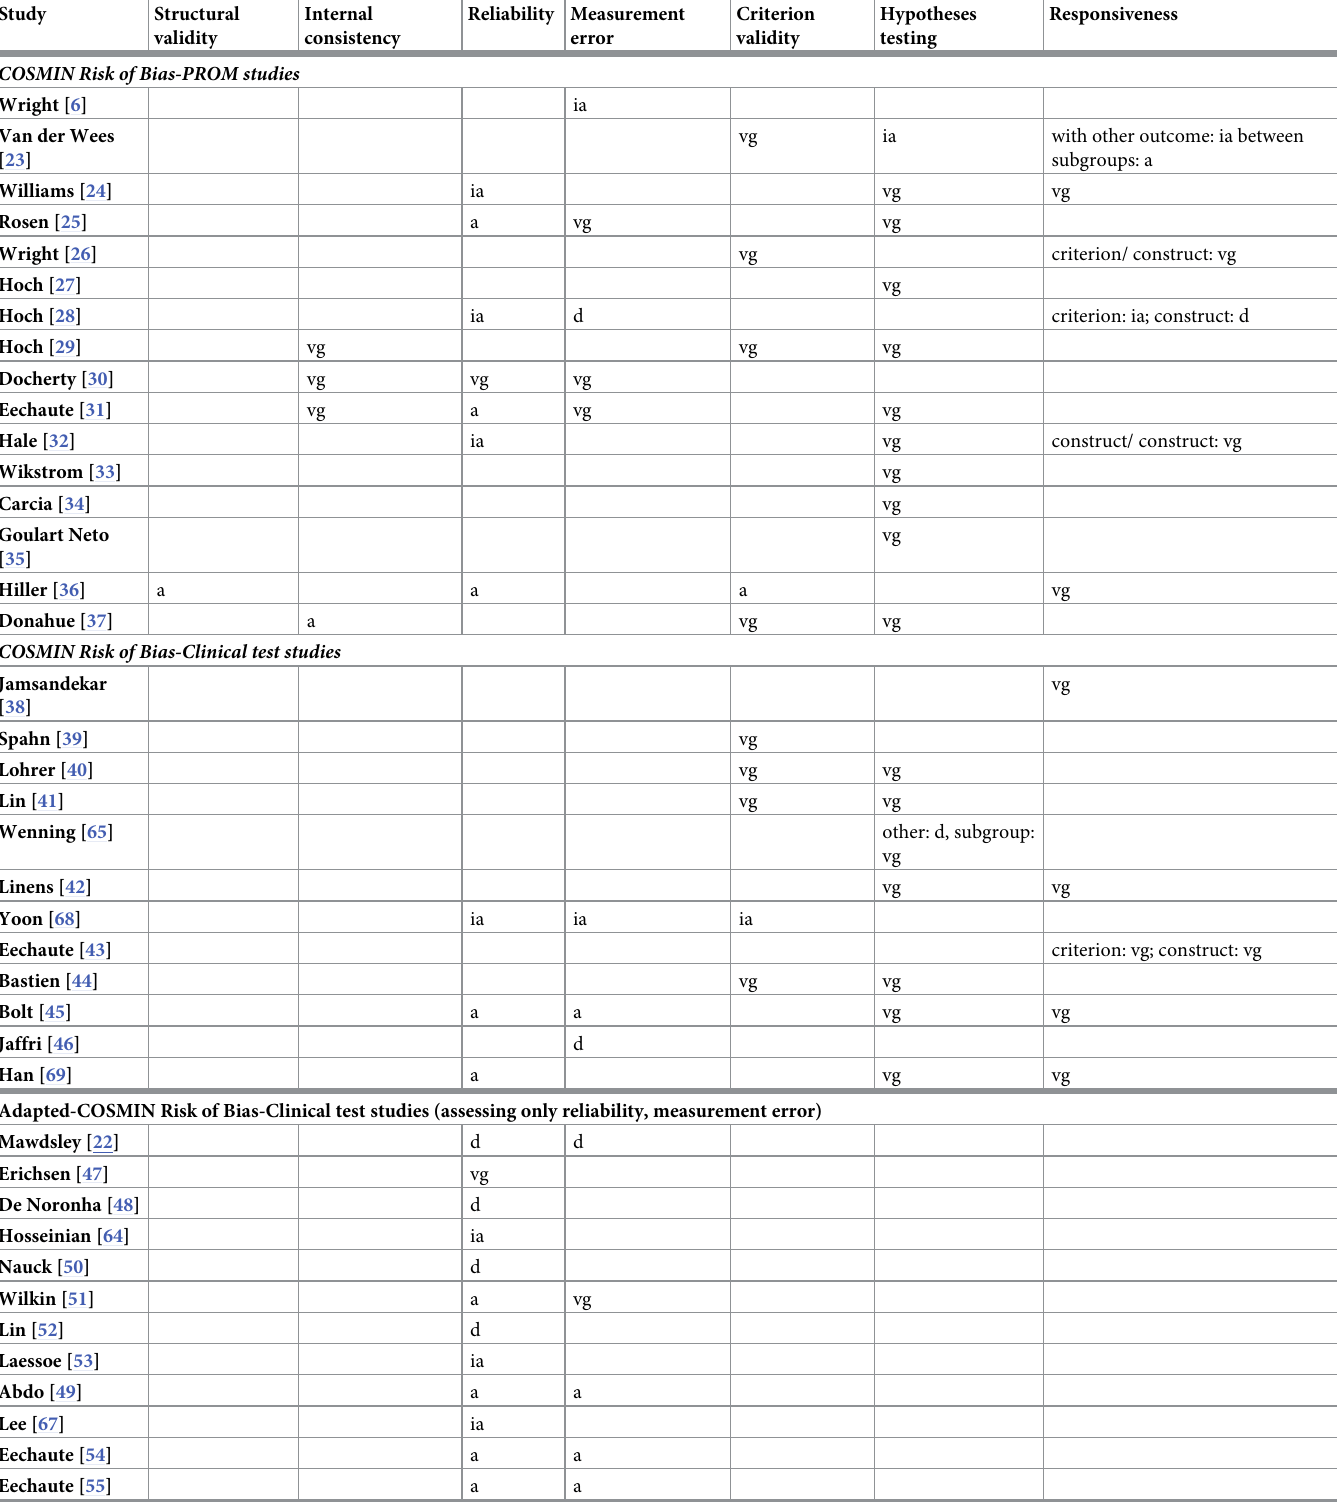
Table 2. Risk of bias rating